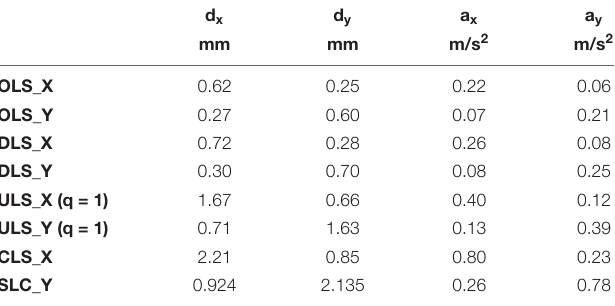
TABLE 3 | Maximum inter-storey drift and maximum floor acceleration for different limit